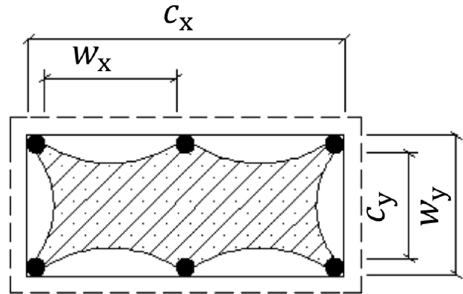
Figure 8. Parameters of effectively-confined concrete area by steel hoops.